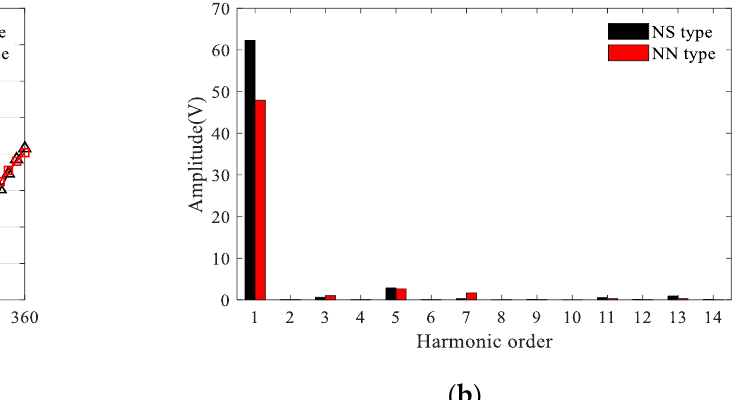
Figure 14. Comparison of no-load phase back EMF waveforms at rated speeds. ( a ) Waveform; ( b ) harmonic spectra.